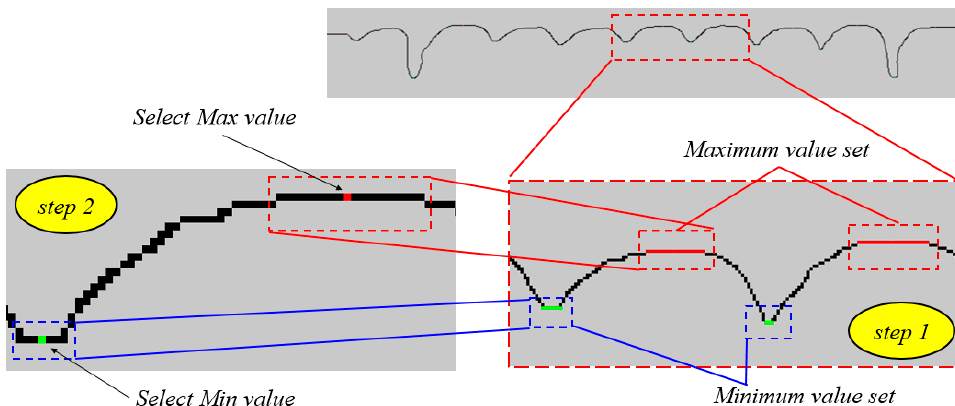
Figure 17. Pole simplification model.